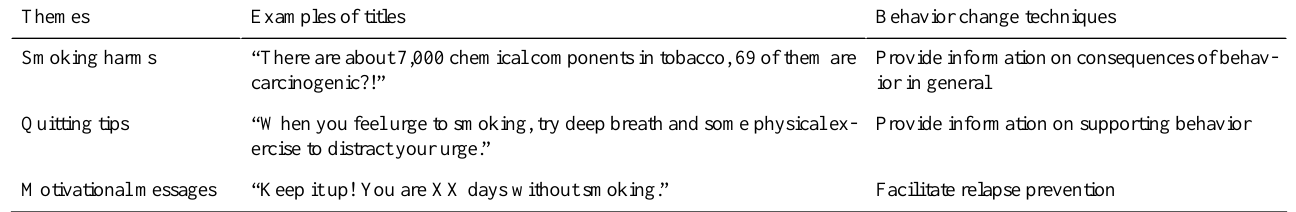
Behavior change techniquesExamples of titlesThemes Provide information on consequences of behav-